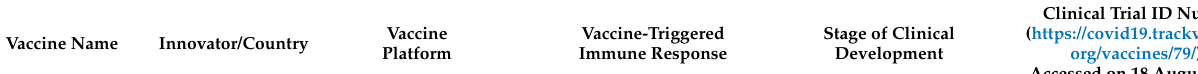
Table 1. Nucleic acid-based vaccine candidates for SARS-CoV-2 in different stages of clinical development.